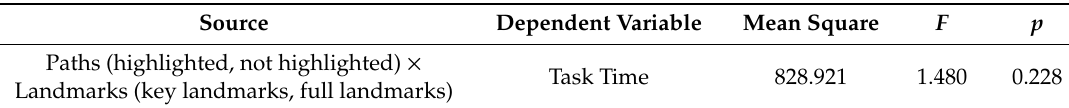
Table 4. Results of task-time interaction test.